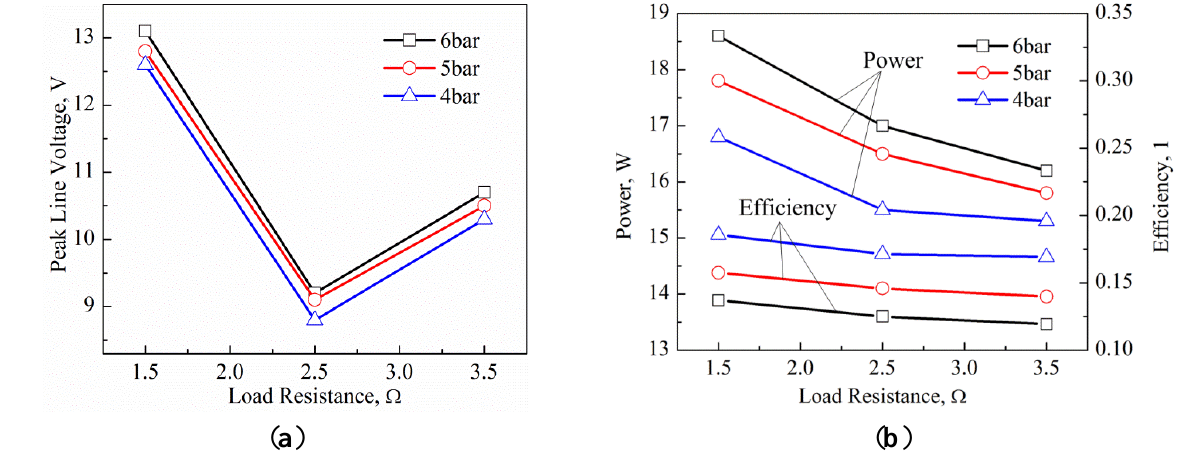
Figure 13. ( a ) The peak line voltage with different load resistance; ( b ) The power and efficiency in different load resistance.